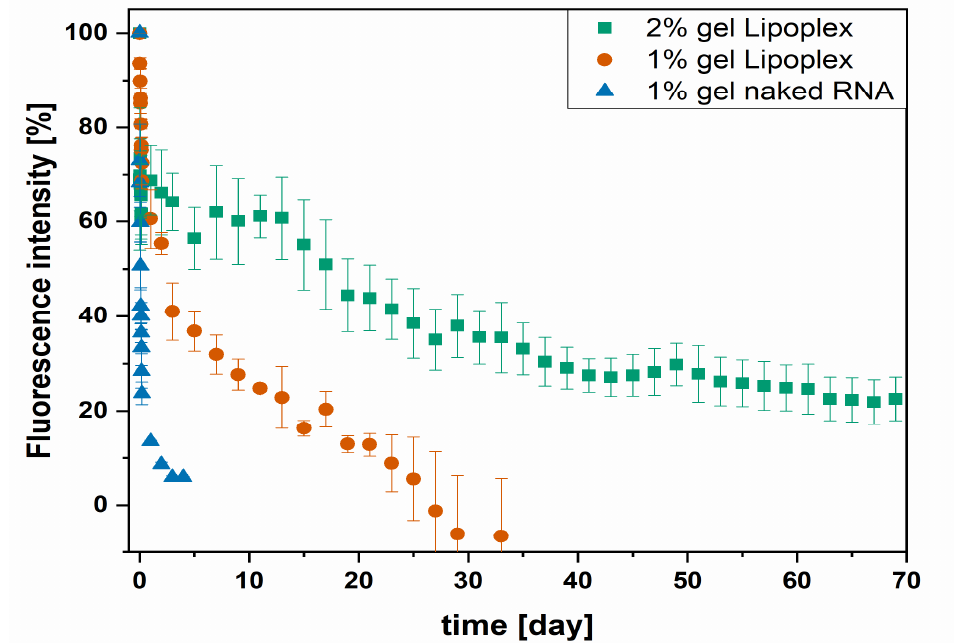
Figure 7. Release of either naked siRNA or lipoplex from the formulation of 1% and 2% gelator concentration.